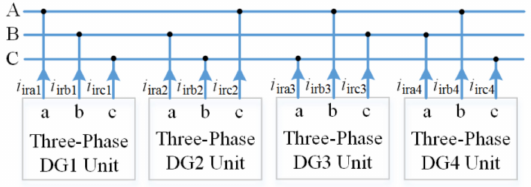
Figure 4. Multiple three-phase DGs.